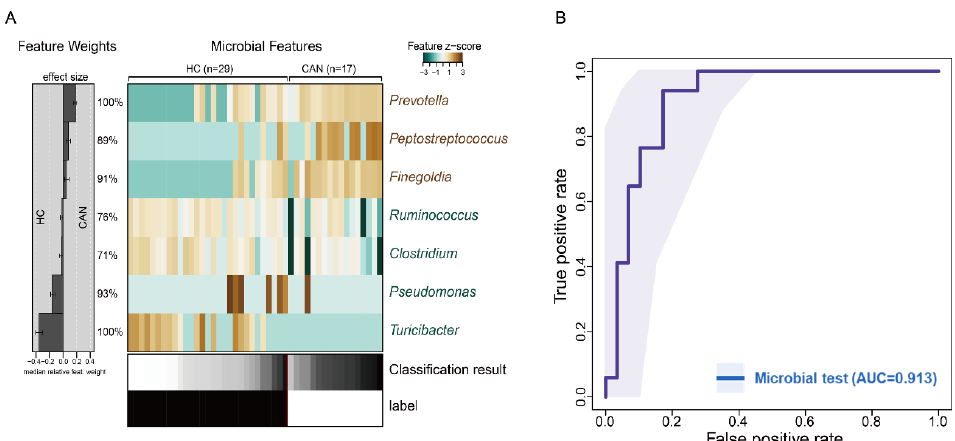
Figure 6. Machine learning analysis. ( A ) Relative abundance of seven fecal-derived genera potentially associated with ICC is presented as a heatmap. The effect size of each marker genera for the classification is displayed to the left. ( B ) Mean test prediction accuracy measured by the area under the ROC curve (AUC). Table 2. Important genera selected by our machine learning model.